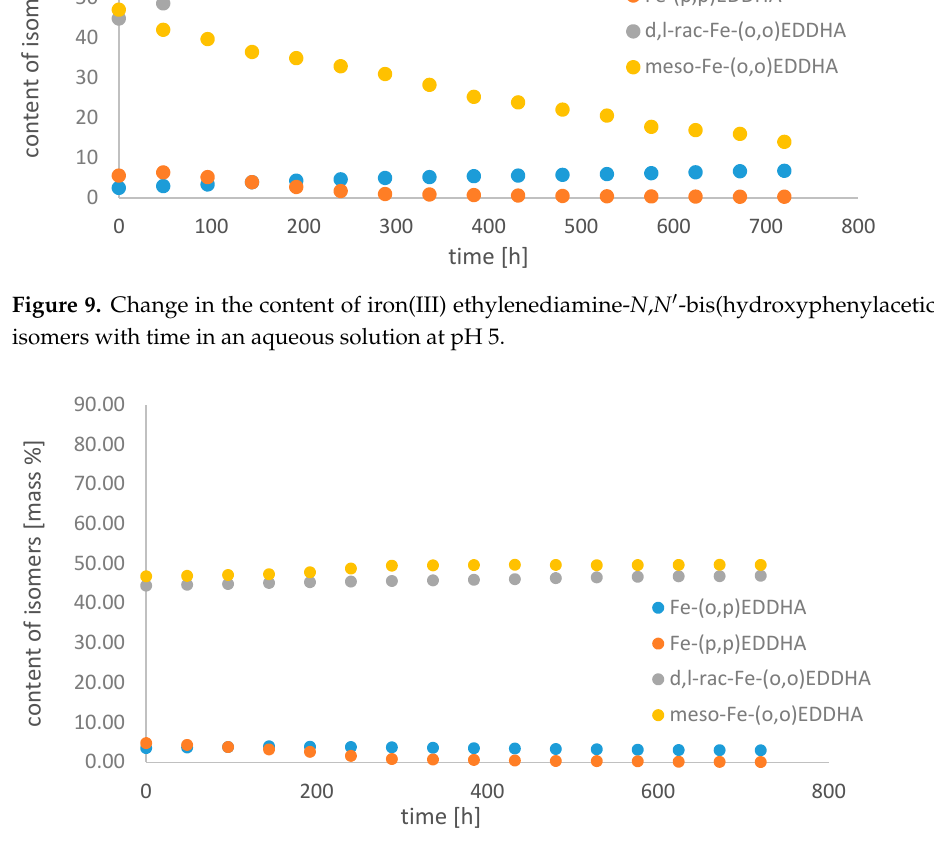
Figure 10. Change in the content of iron(III) ethylenediamine- N,N ′ -bis(hydroxyphenylacetic) acid isomers with time in an aqueous solution at pH 7.